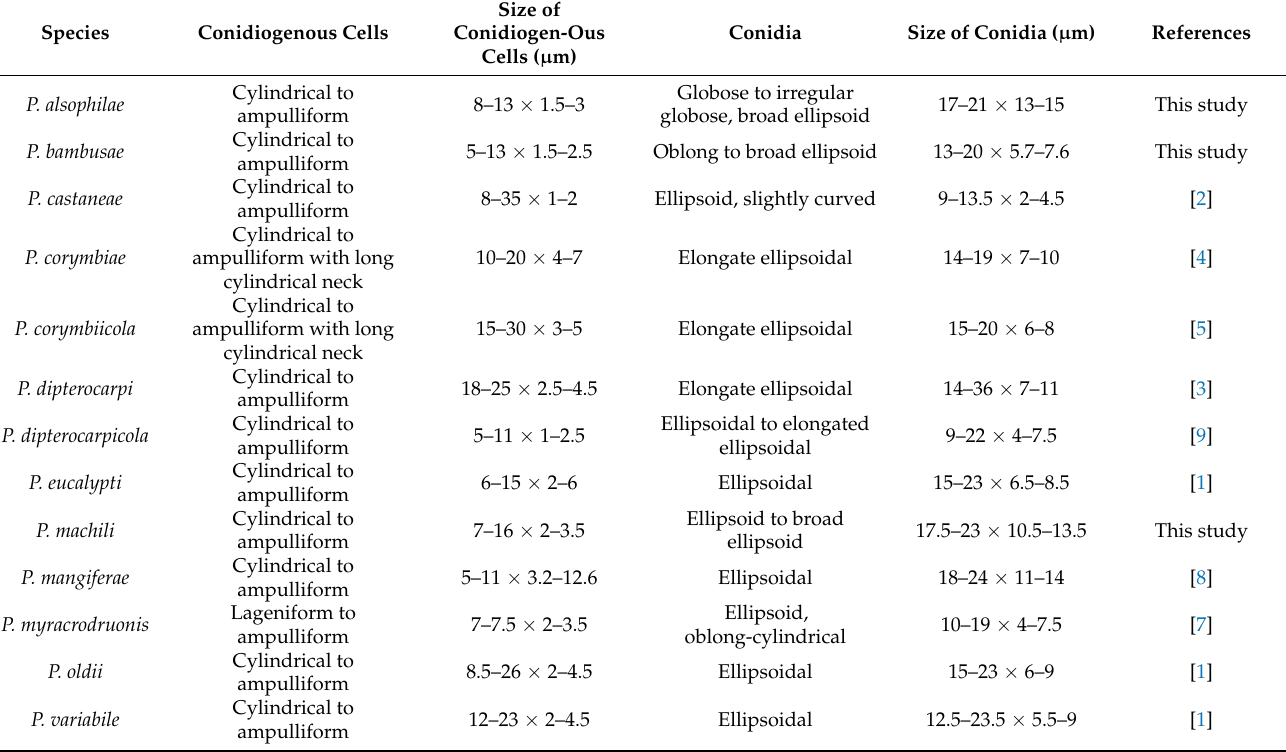
Table 4. Asexual morphological features of Pseudoplagiostoma